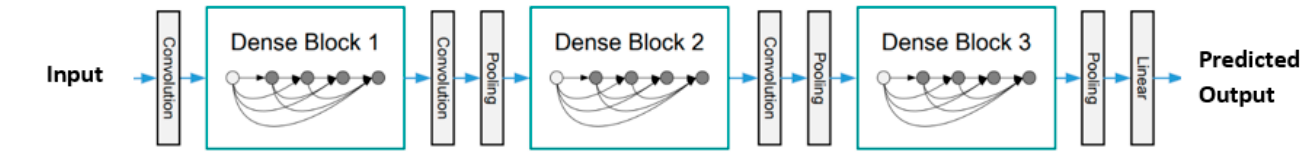
Figure 1. The architecture of the Figure 1 . The architecture of the BoxENet .